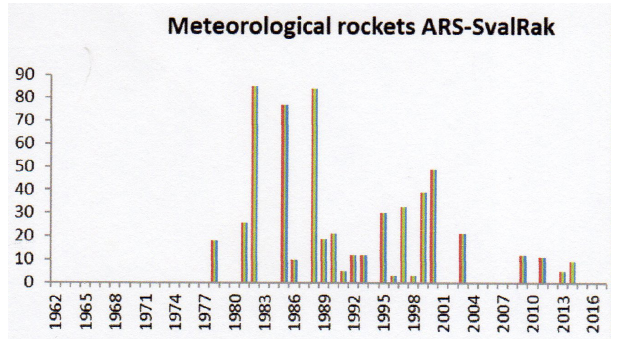
Figure 8. Total number of meteorological rockets